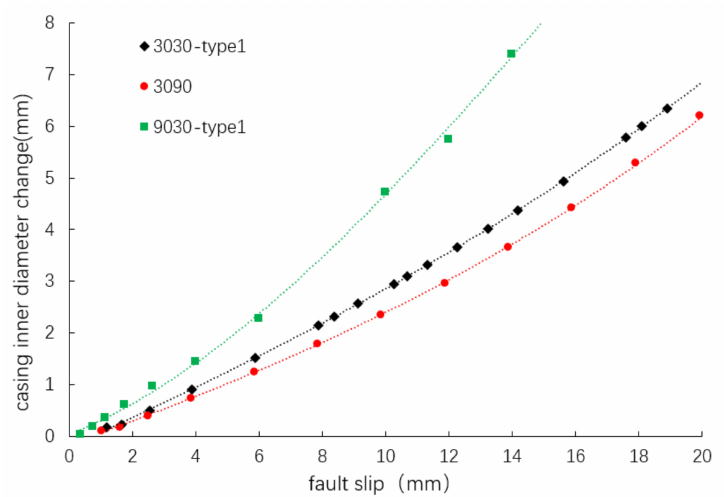
Figure 15. The relationship between fault slip and casing inner